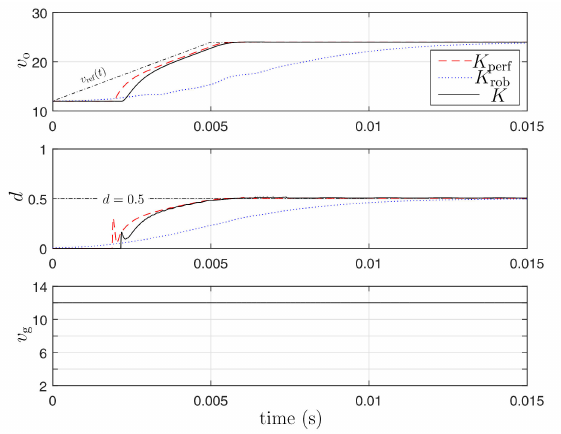
Figure 7. Simulated transient of the boost converter during startup with Vg = 12 V, for the three controllers K (solid line), K perf (dashed line) and K rob (dotted line). Top waveforms: output voltage. Middle waveforms: duty cycle. Bottom waveform: input